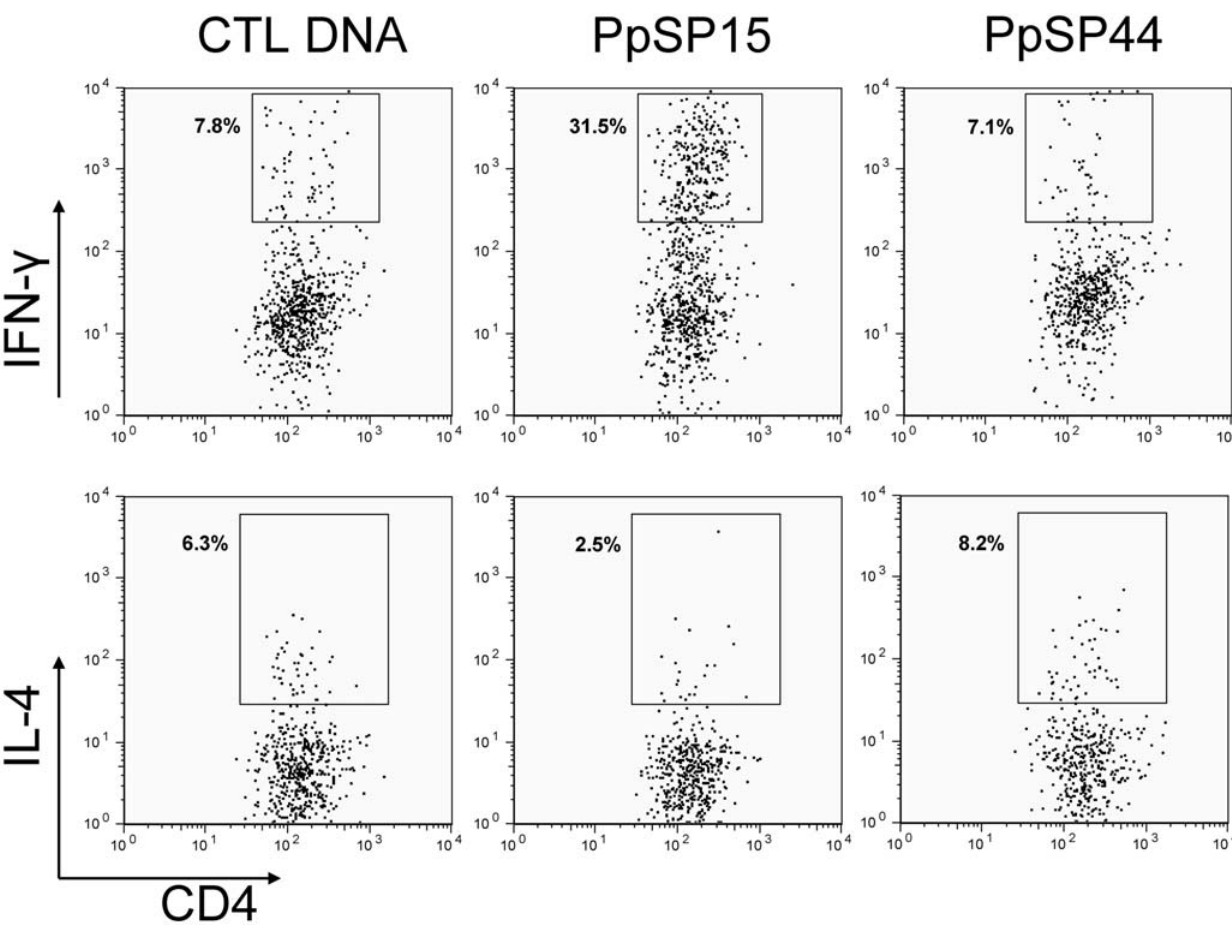
Figure 4. Frequency of CD4 + -T cells producing IFN- c or IL-4 in mice immunized with PpSP15 or PpSP44. Mice immunized in the right ear with CTL DNA, PpSP44 or PpSP15 were challenged in the left ear with 500 L. major metacyclics and 0.5 pairs of SGH. Two weeks after challenge, the percentage of CD4 + T cells producing IFN- c or IL-4 were determined in cells recovered from the ear dermis (pools of three to five ears). Twelve hours after stimulation with SLA, cells were incubated for four hours with monensin, PMA and ionomycin and stained with CD4, TCR b , IFN- c and IL-4. The numbers represent the percentage of positive events. Data are representative of three independent experiments.